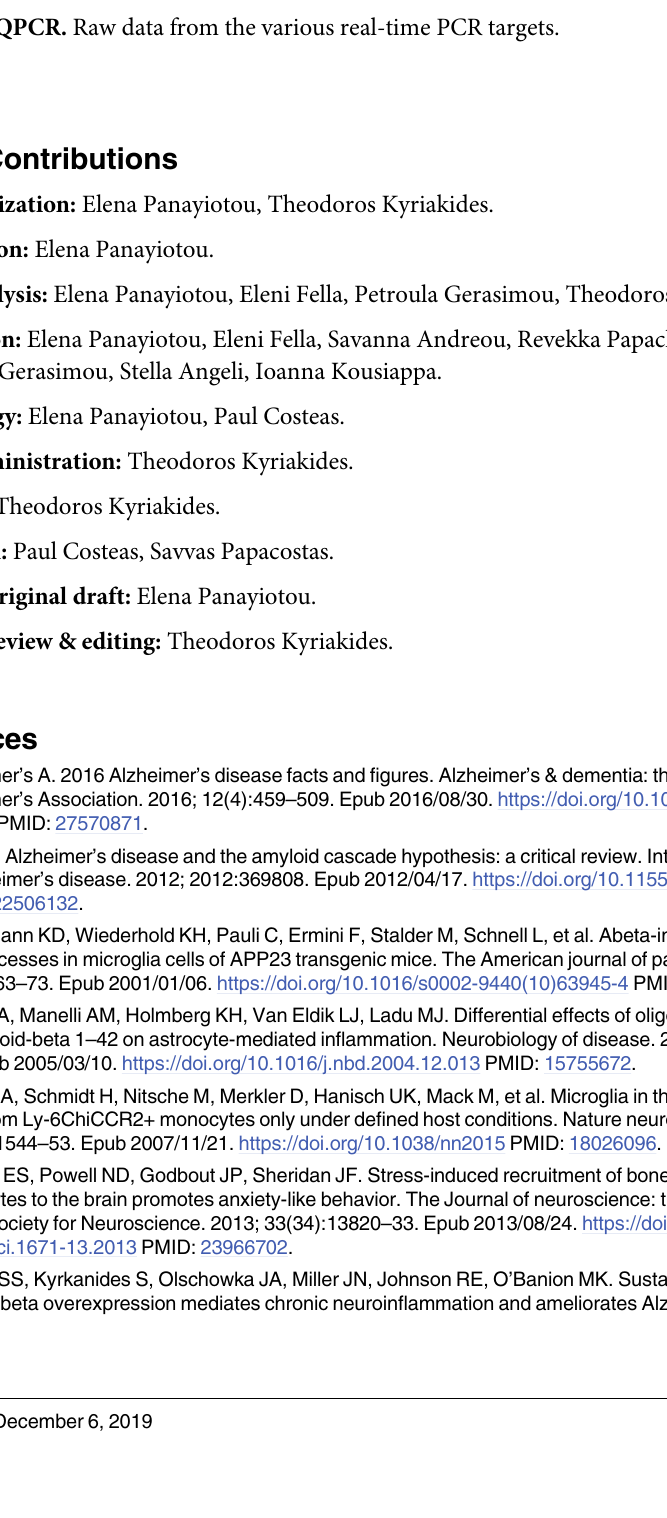
S1 Fig. Immunoblots. Raw data from immunoblot experiments. (TIF) S2 Fig. Immunoassays. Raw data from A β 42 and A β 40 immunoassay kits. (TIF) S3 Fig. Y-maze. Raw data obtained during Y-maze spontaneous alternation test. (TIF) S4 Fig. RT-QPCR. Raw data from the various real-time PCR targets.